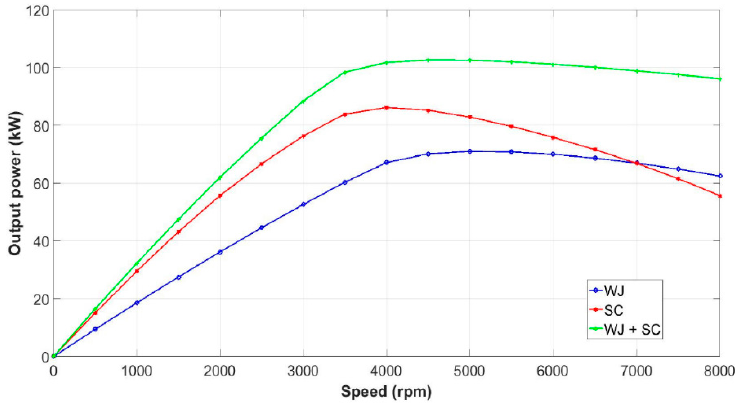
Figure 25. Variation in continuous output power with spray-cooling and without spray-cooling [76].